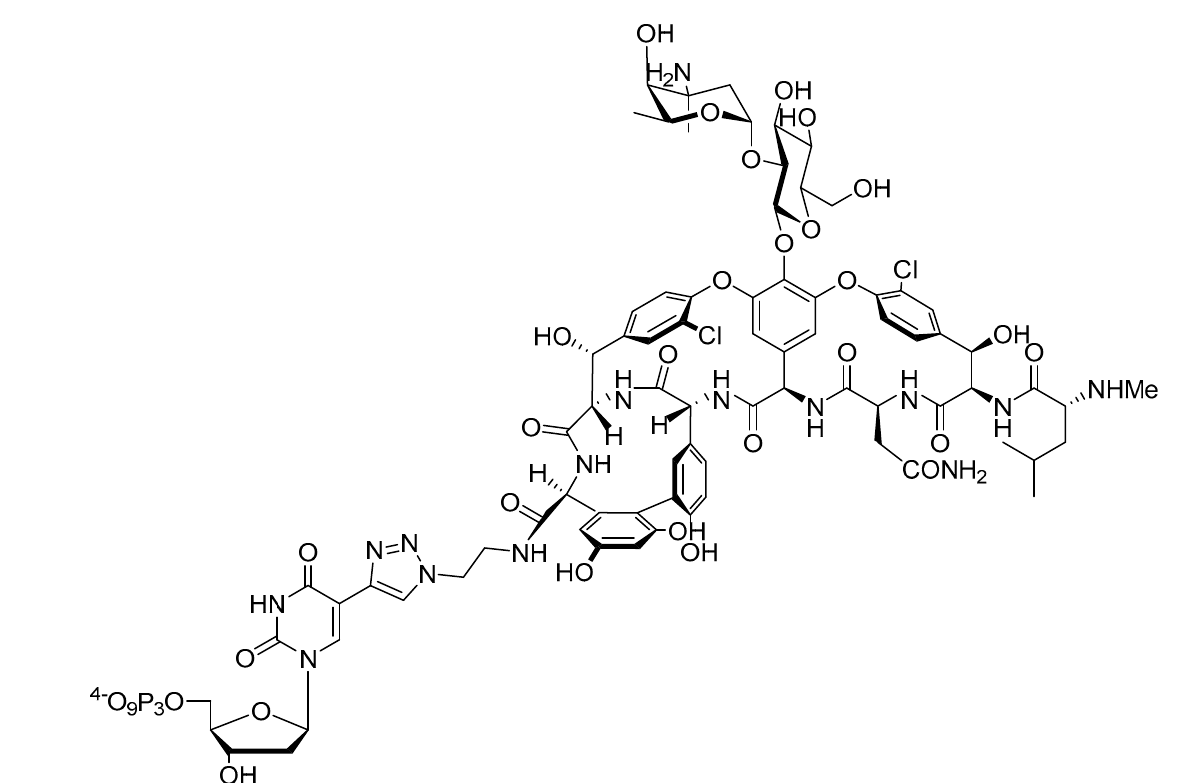
Figure 2. Chemical structure of modified nucleotide dU Van TP.